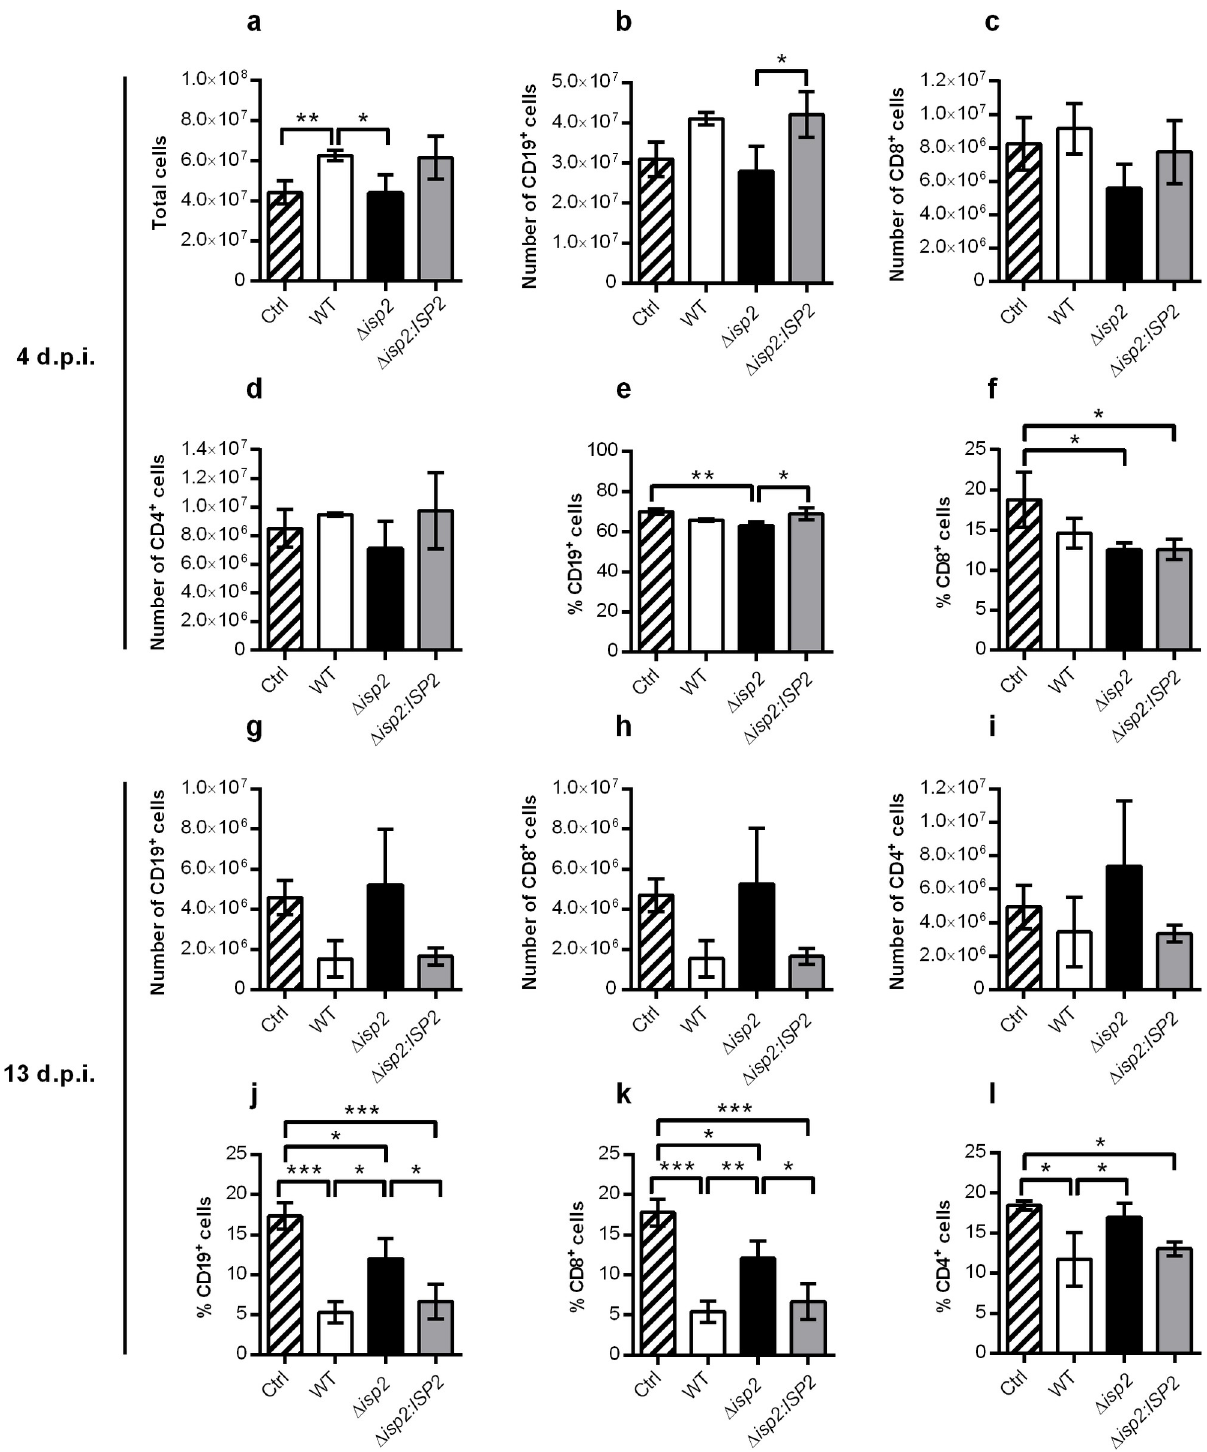
Fig 5. Distribution of spleen lymphocyte populations during early and late infection. C57BL/6 mice were infected intraperitoneally with 1 × 10 5 T . b . rhodesiense WT, Δ isp 2 and Δ isp 2: ISP 2.Uninfected mice were used as a control (Ctrl). After 4 days (top panel) or 13 days (bottom panel), mice were euthanized, perfused, and the spleens were removed and homogenized. Cell suspensions were counted to give (a) the total cells per spleen, and then stained with antibodies for extracellular markers for flow cytometry. Cells were first gated to exclude debris using the FSC vs. SSC plot followed by FSC-H vs. FSC-A to exclude doublets. CD19 + cells were gated using a SSC vs. APC-CD19 plot, while CD4 + and CD8 + cells were gated on a FITC-CD4